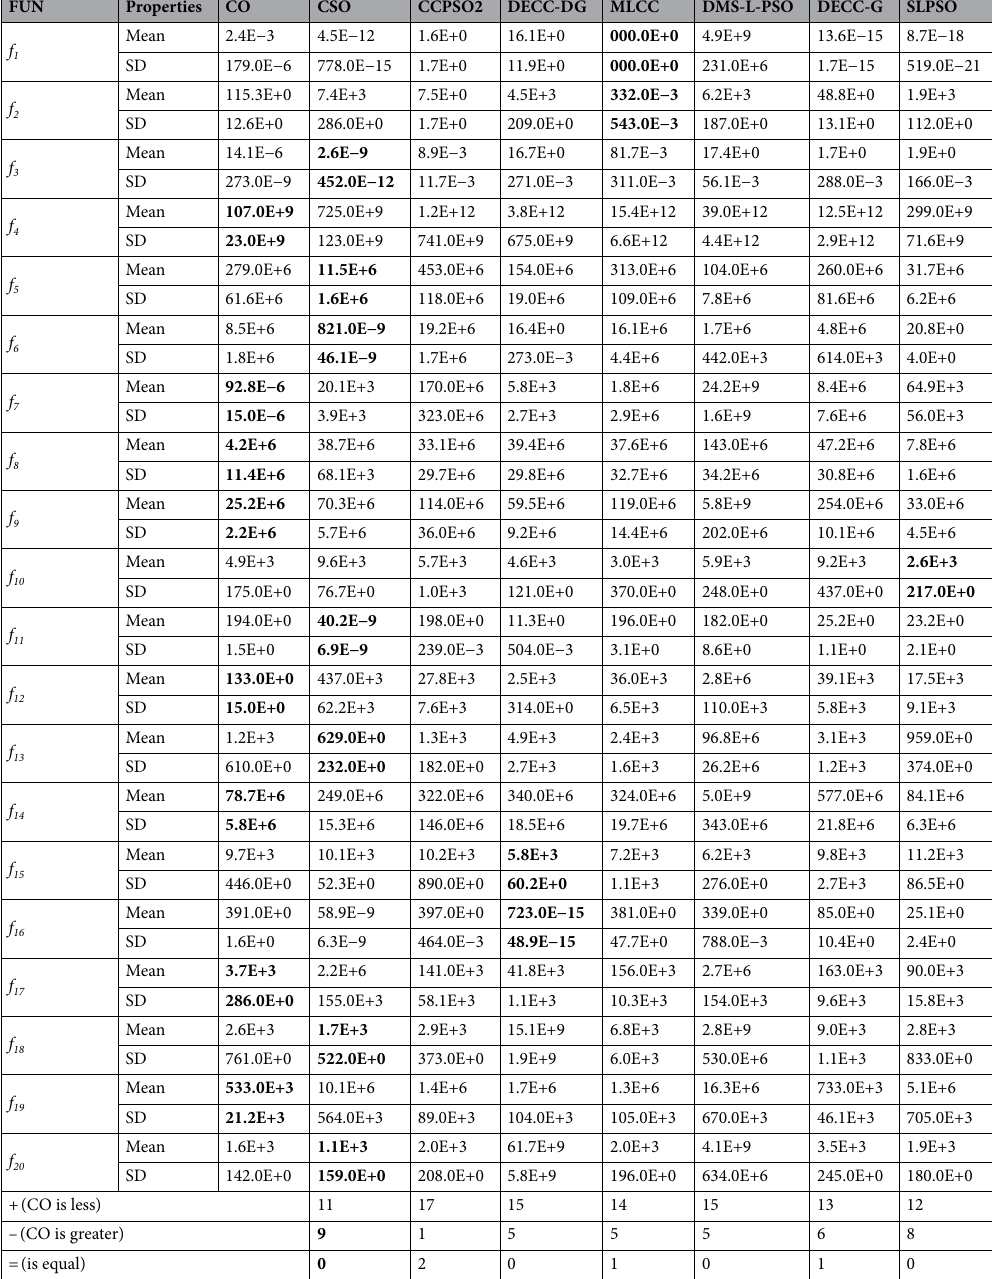
Table 6. Comparison of results of CO and state-of-the-art methods on the CEC2010 large-scale functions. Significant values are in